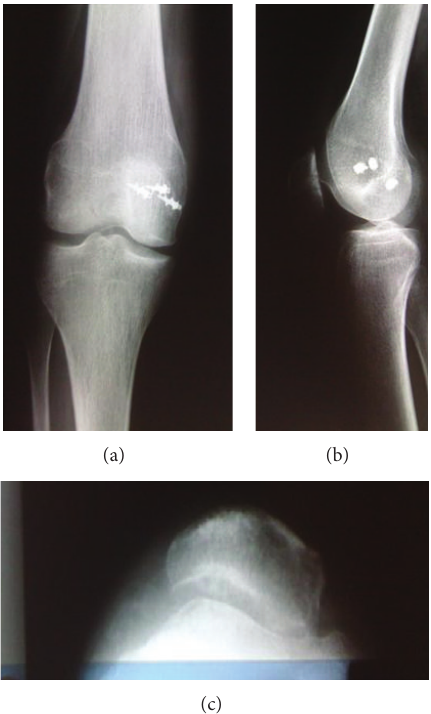
Figure 5: Postoperative X-rays of the knee: (a) anteroposterior, (b) lateral, and (c) tangential patellofemoral views at 60 ∘